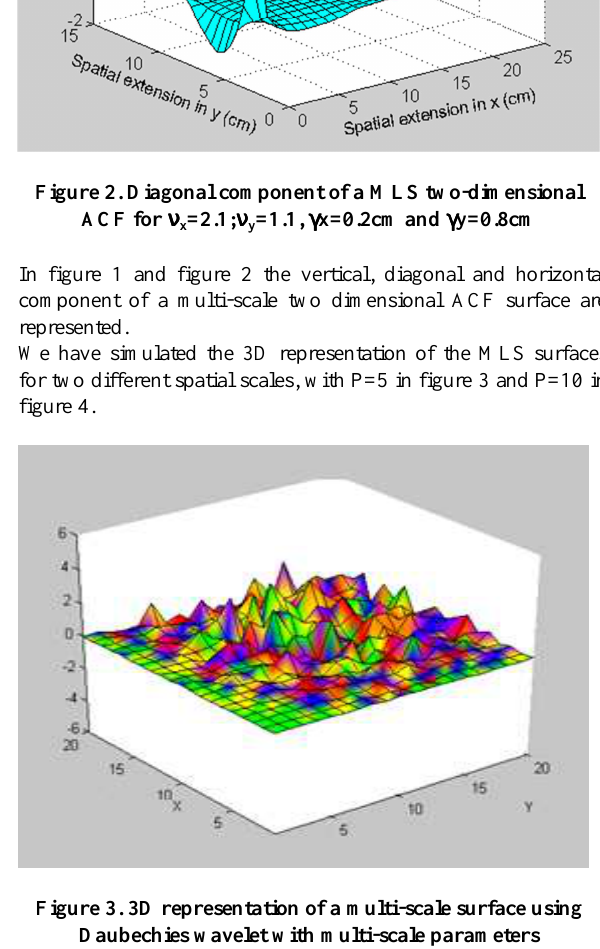
Figure 3. 3D representation of a multi-scale surface using Daubechies wavelet with multi-scale